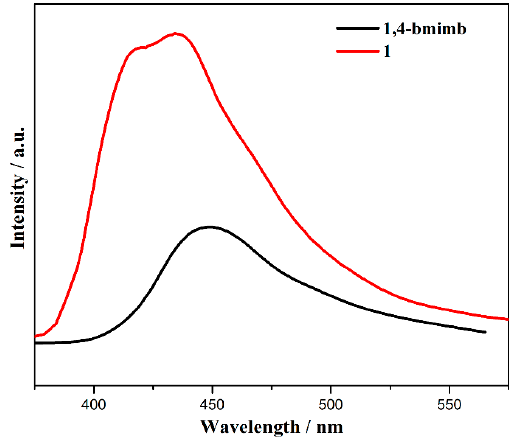
Figure 6. Fluorescence spectra of compound 1 and 1,4-bmimb ligand.